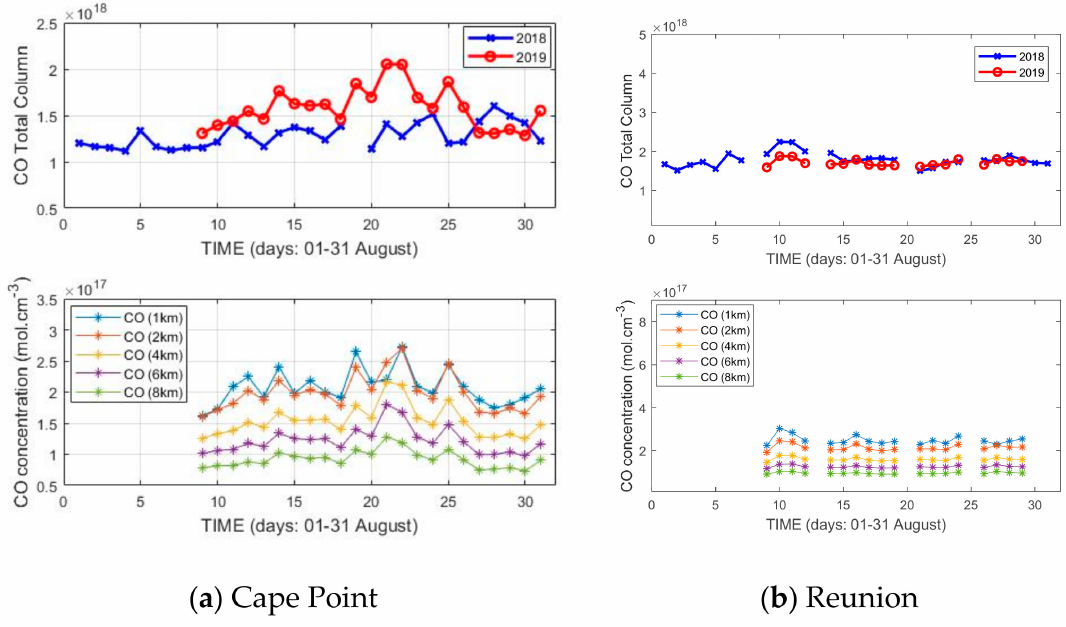
Figure 7. Same as Figure 4, but for ( a ) Cape Point (34.58 ◦ S, 18.83 ◦ E) and ( b ) Reunion island (21.18 ◦ S, 55.88 ◦ E)